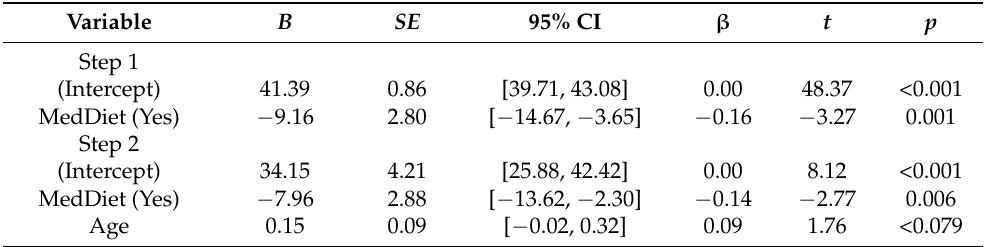
Table 10. Summary of hierarchical regression analysis for MedDiet predicting Symptom Score.